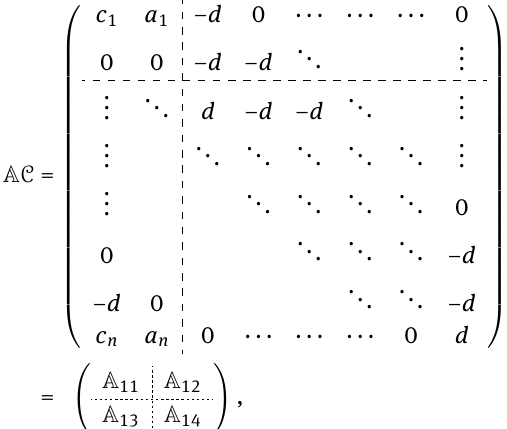
Algorithm 1. Compute the determinant of the Toeplitz tridiagonal matrix with perturbed columns A defined in